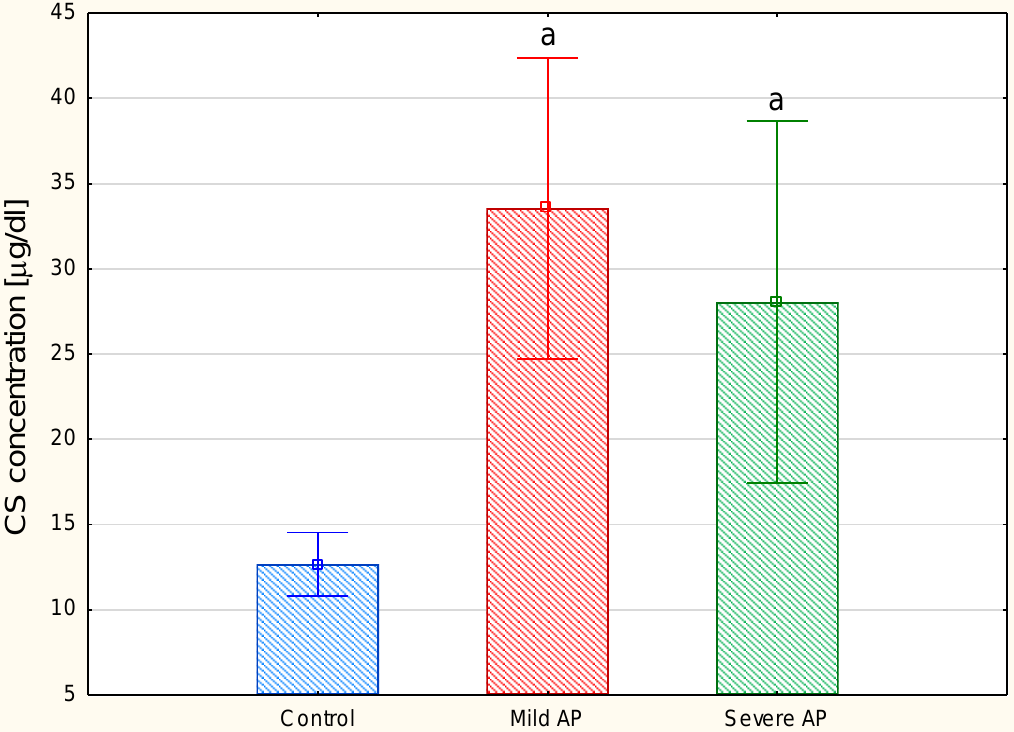
Figure 4. Concentrations of the circulating chondroitin sulfate (CS) in the healthy controls and the patients with mild or severe acute pancreatitis (AP). CS was identified in the samples of plasma glycosaminoglycans using a combination of electrophoresis on the cellulose acetate and specific degradation with chondroitinase ABC. Data are presented as means ± SD. a — differences statistically significant ( p < 0.05) compared to the healthy controls.